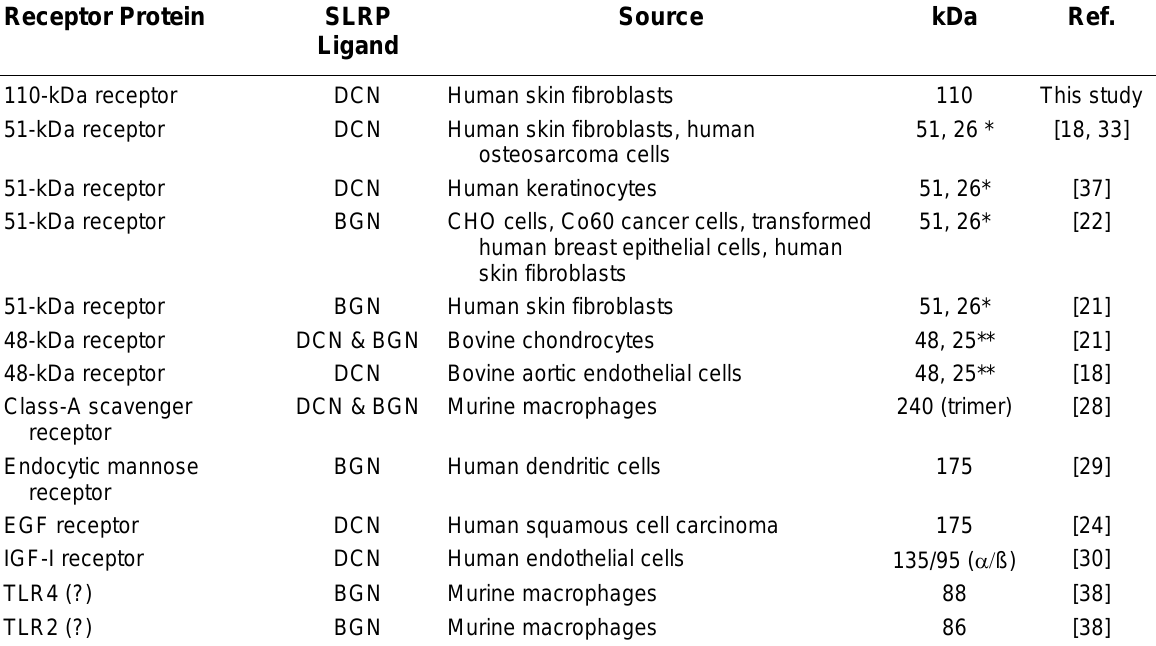
Putative Decorin/Biglycan Endocytosis